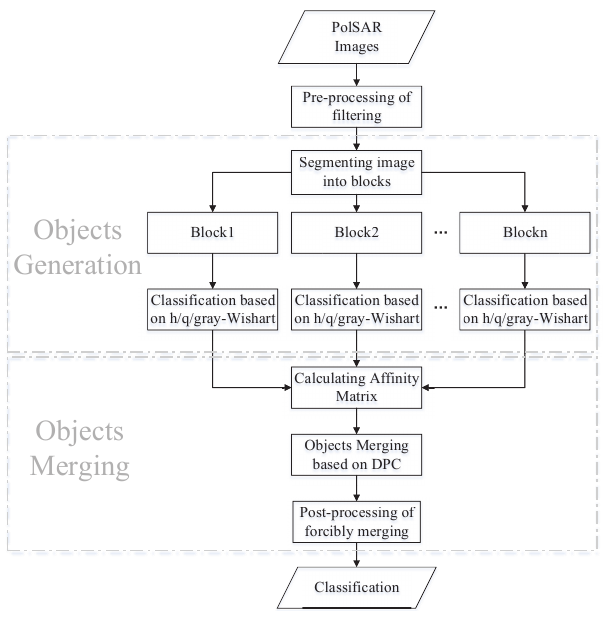
Figure 1. Flow chart of the proposed